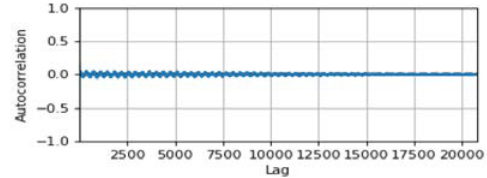
Figure 3. Autocorrelation of 1961-2017 Malaybalay